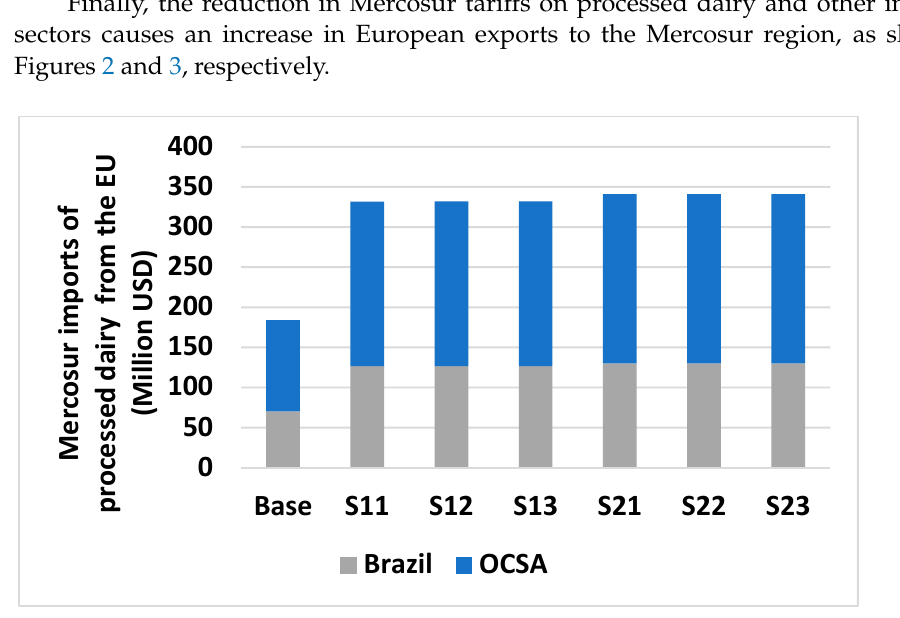
Figure 2. Mercosur imports of processed dairy from the EU (million USD) .